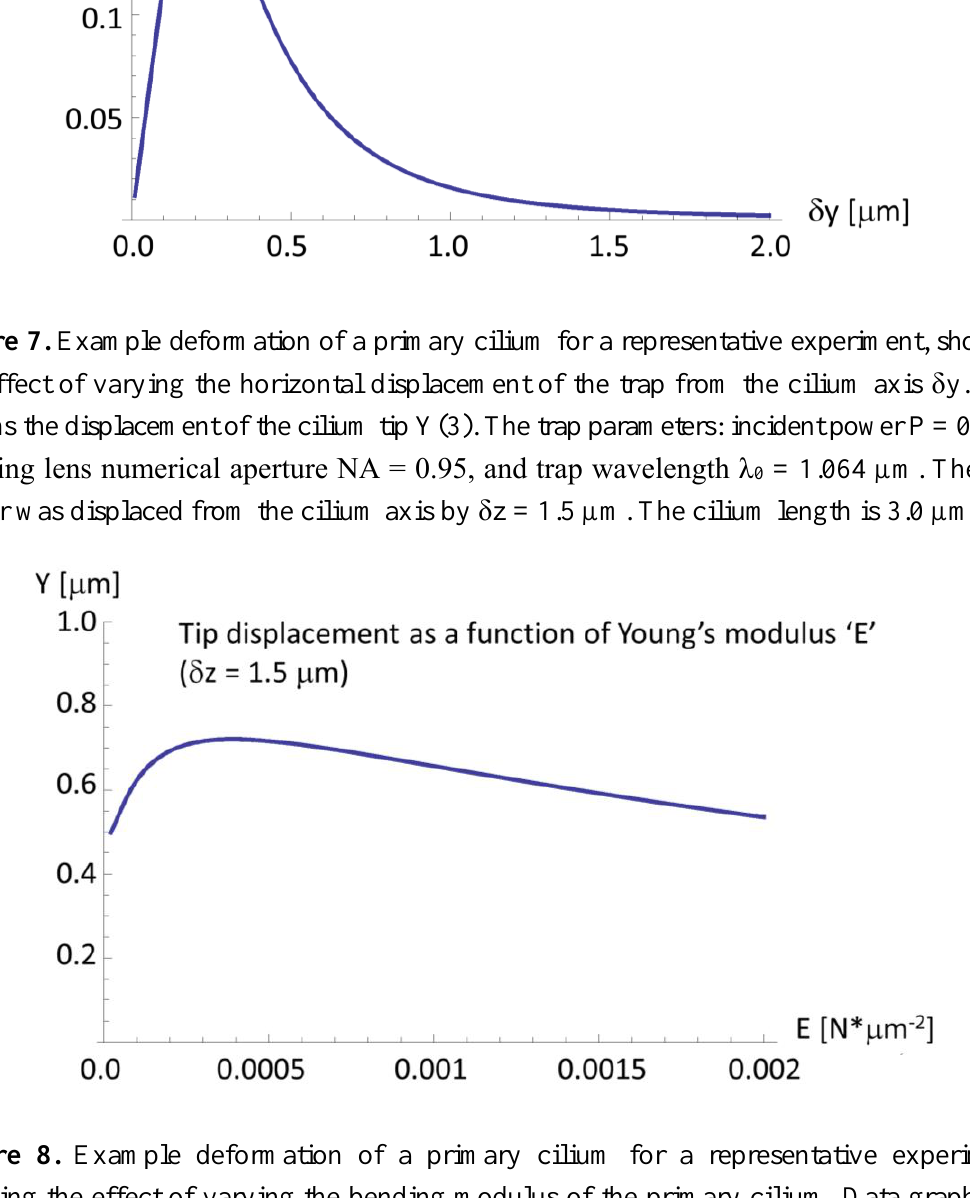
Figure 8. Example deformation of a primary cilium for a representative experiment, showing the effect of varying the bending modulus of the primary cilium. Data graphs the displacement of the cilium tip Y(3). The trap parameters: incident power P = 0.5W, trapping lens numerical aperture NA = 0.95, and trap wavelength λ 0 = 1.064 µm. The trap center was displaced from the cilium axis by δy = 0.5 µm and δz = 1.5 µm. The cilium length is 3.0